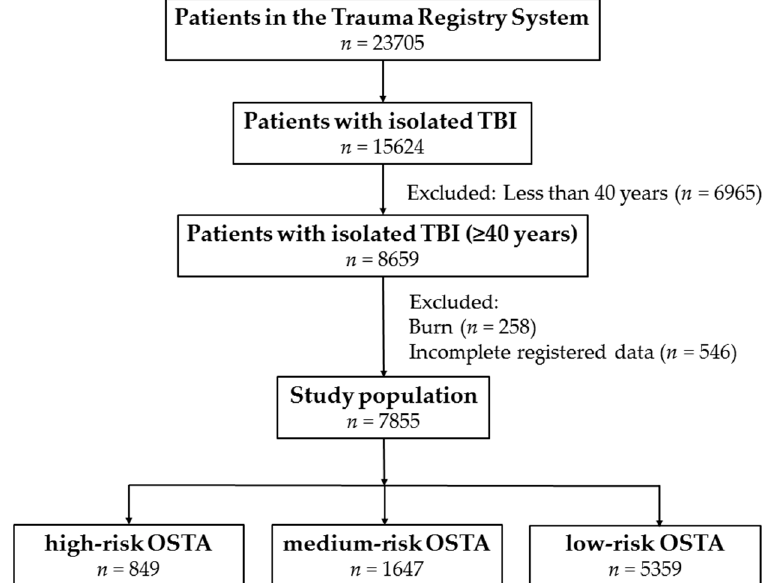
Figure 1. Flow chart of the studied trauma patients with isolated moderate and severe TBI. TBI: traumatic brain injury; OSTA: Osteoporosis Self-Assessment Tool for Asians.